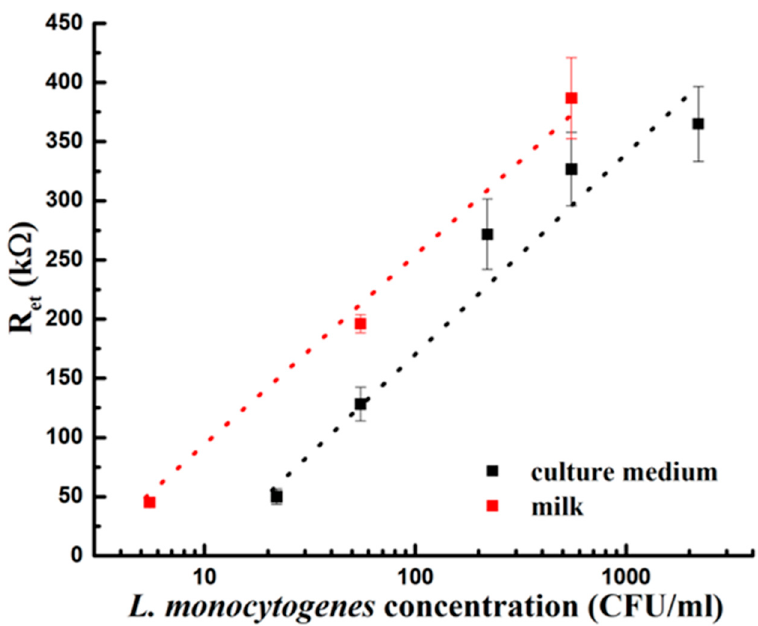
Figure 6. Calibration curves for culture medium (black) and milk (red) spiked samples.